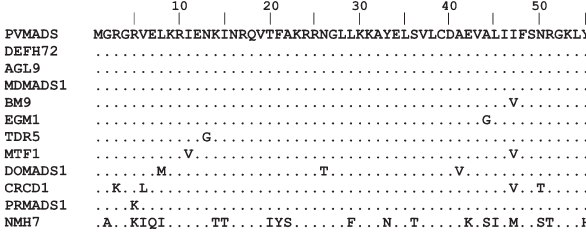
Figure 2 - Nucleotide and deduced amino acid sequences of a putative MADS-box sequence of Phaseolus vulgaris (PVMADS). The imperfect microsatellite motif (GA) 26, contiguous to the N-terminal of MADS- sequence, is in italics